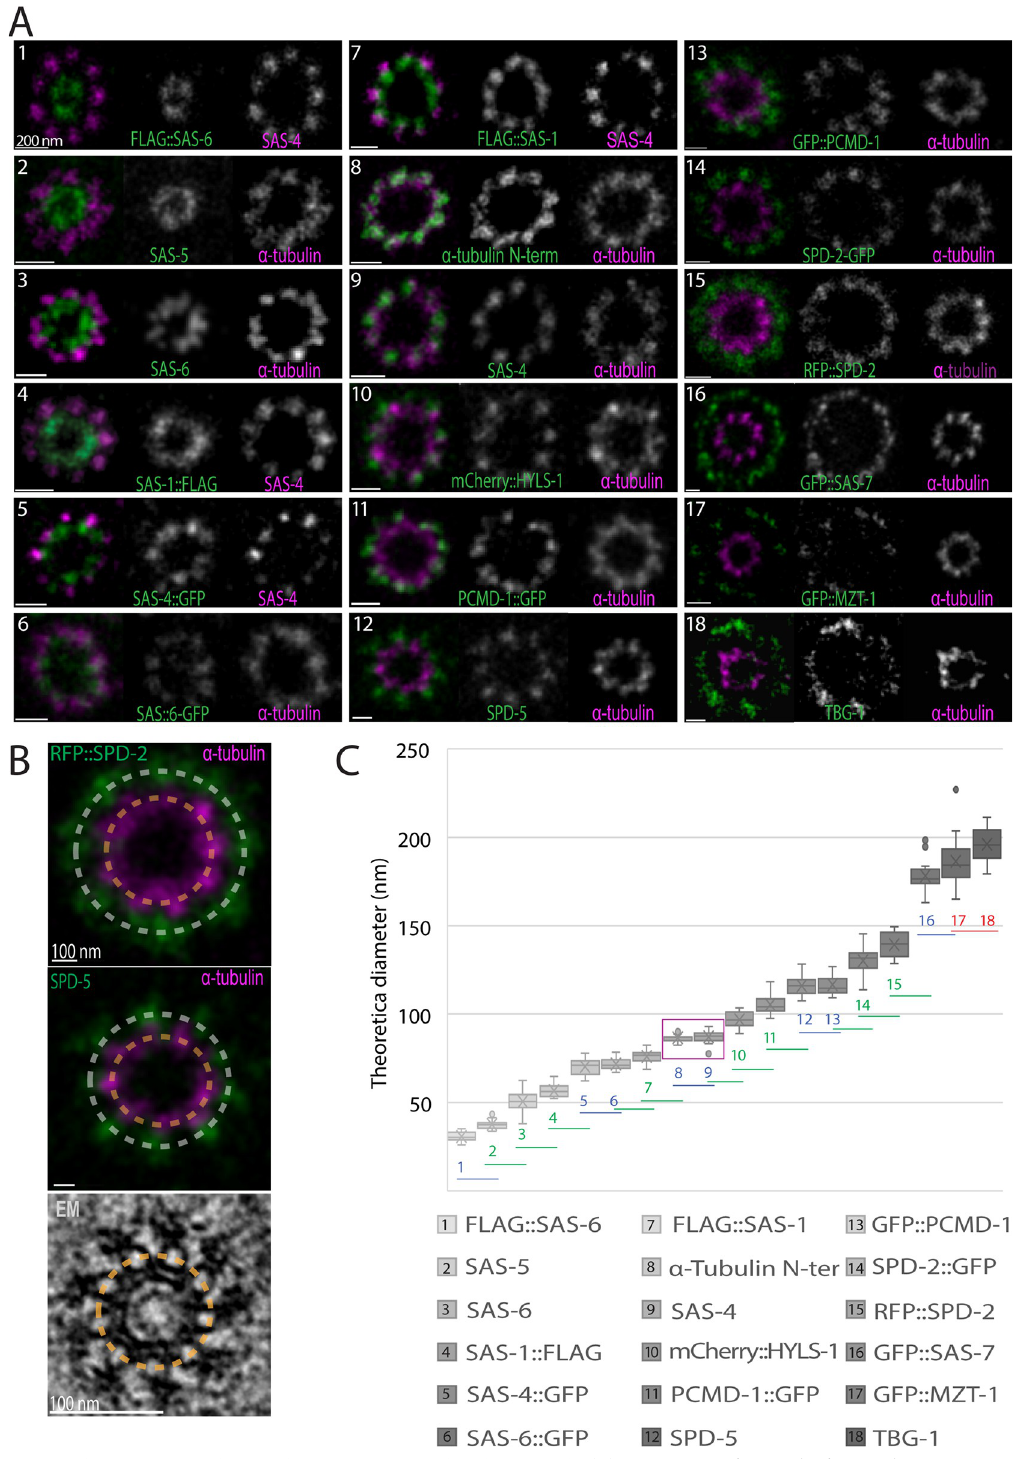
Fig 3. Relative position of centriolar components within the centriole. (A) U-Ex-STED of centrioles from early meiotic prophase stained for the indicated proteins. Each component (green) was imaged together with either α -tubulin (visualized with an antibody recognizing the C-terminus of the protein) or SAS-4 (visualized with an antibody raised against amino acid 350–517 of the protein) (both magenta), which served as standards for the quantification in C. (B) Examples of fitted rings on fluorescent signal used to calculate the diameter of each component relative to α -tubulin or SAS-4 standards. In each